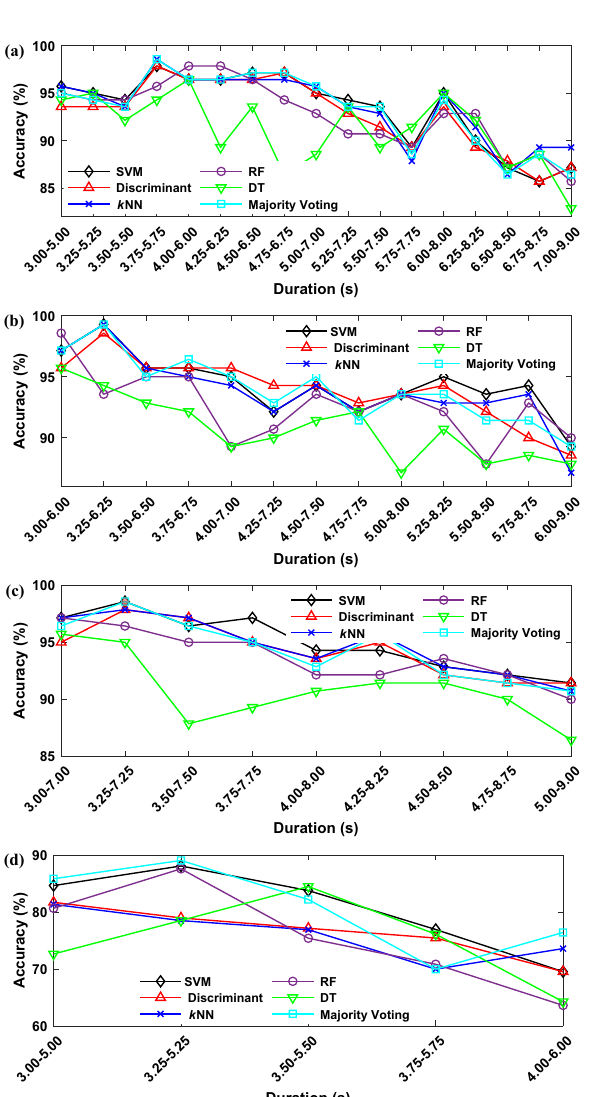
Figure 11. Effect of the location of sliding window on the classification accuracy. ( a ) two-second sliding window for dataset II–III ( b ) three-second sliding window for dataset II–III ( c ) four-second sliding window for dataset II–III, (d) two-second sliding window for dataset